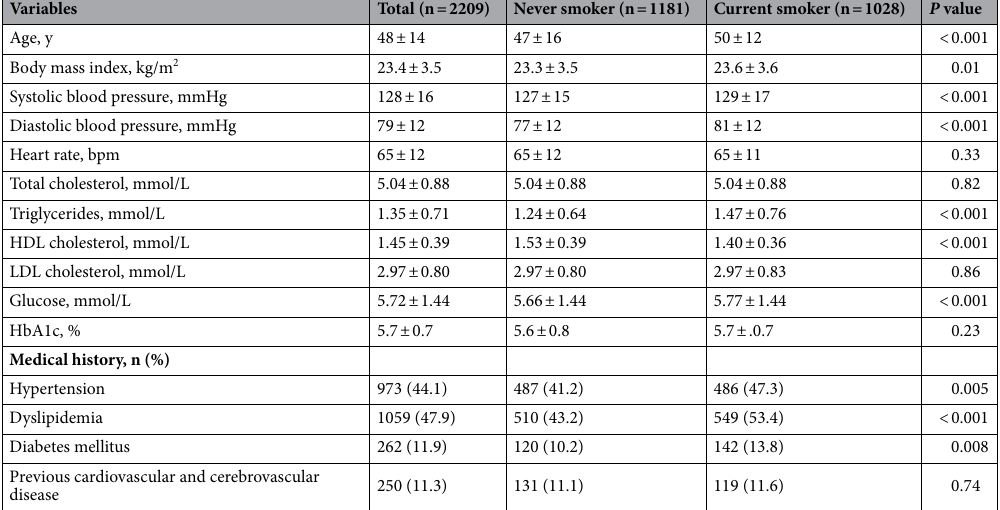
Table 1. Clinical characteristics of never and current smokers in men. All results are presented as mean ± SD. HDL, high-density lipoprotein; LDL, low-density lipoprotein.